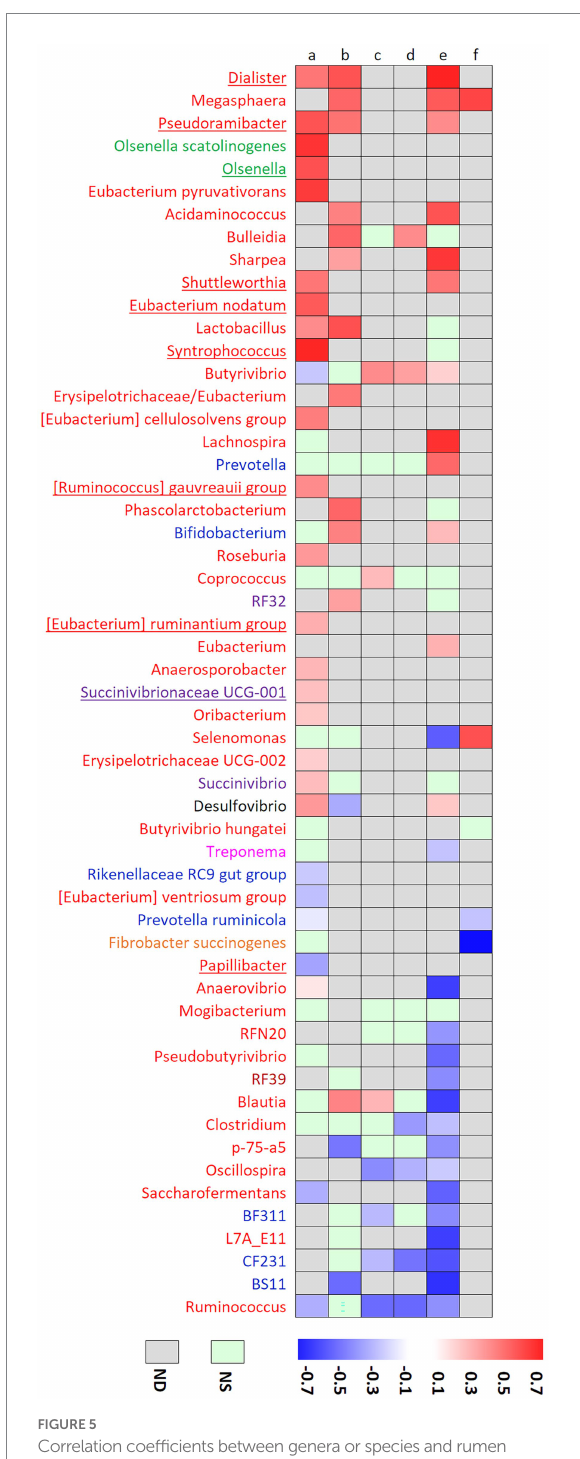
FIGURE 5 Correlation coefficients between genera or species and rumen trans-10 / trans-11 ratio in our experiment (a) and the experiment of Dewanckele et al. (2019) (b), or with trans-10 isomers percentage in the liquid (c) or solid (d) phases of the rumen in the experiment of Pitta et al. (2018), or with milk percentages of trans-10 C18:1 in the experiments of Pitta et al. (2020) (e) and Rico et al. (2015) (f). Only taxa analyzed in our study or at least two studies were selected. Color name coding represents the phylum to which each genus belongs: Actinobacteria (green), Bacteroidetes (blue), Desulfobacterota (black), Fibrobacteres (orange), Firmicutes (red), Proteobacteria (purple), Spirochaetae (pink) and Tenericutes (brown). sPLS-DA discriminant genera are